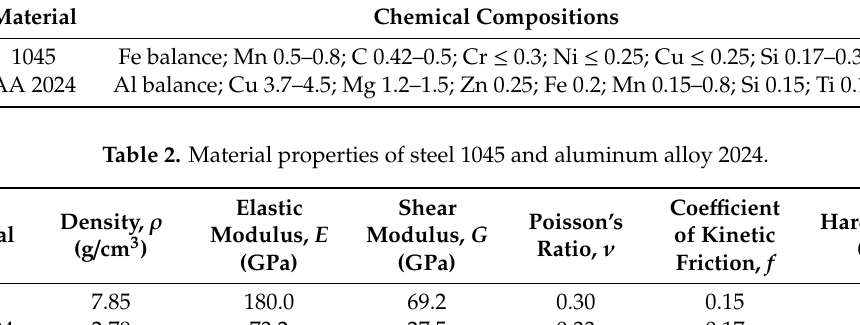
Table 1. Chemical compositions of steel 1045 and aluminum alloy 2024.